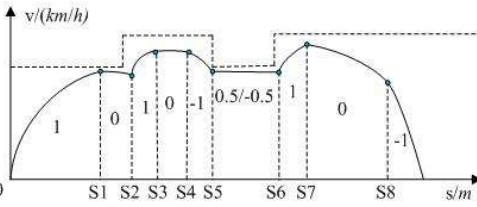
Figure 3. Diagram of train operation mode